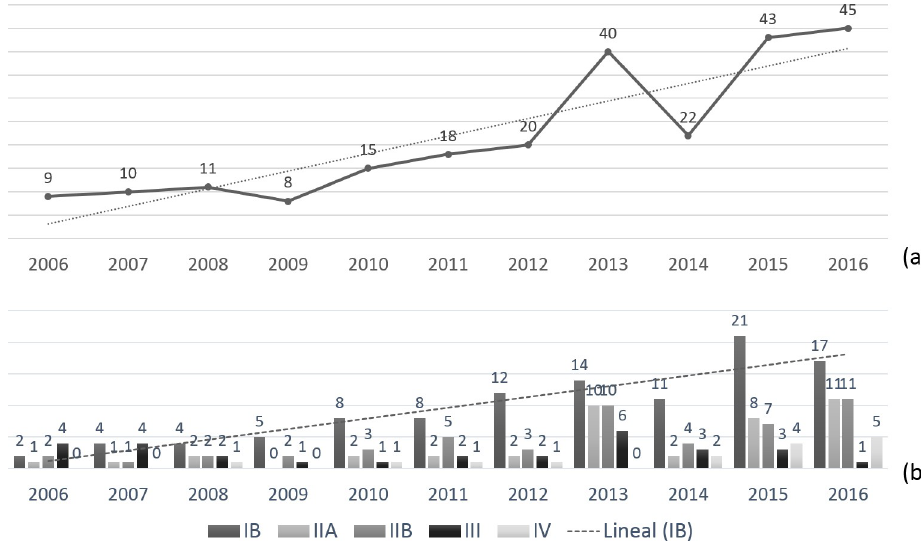
Fig 2. (a) Number of selected papers over publication years. (b) Number of references per year and level of scientific evidence.